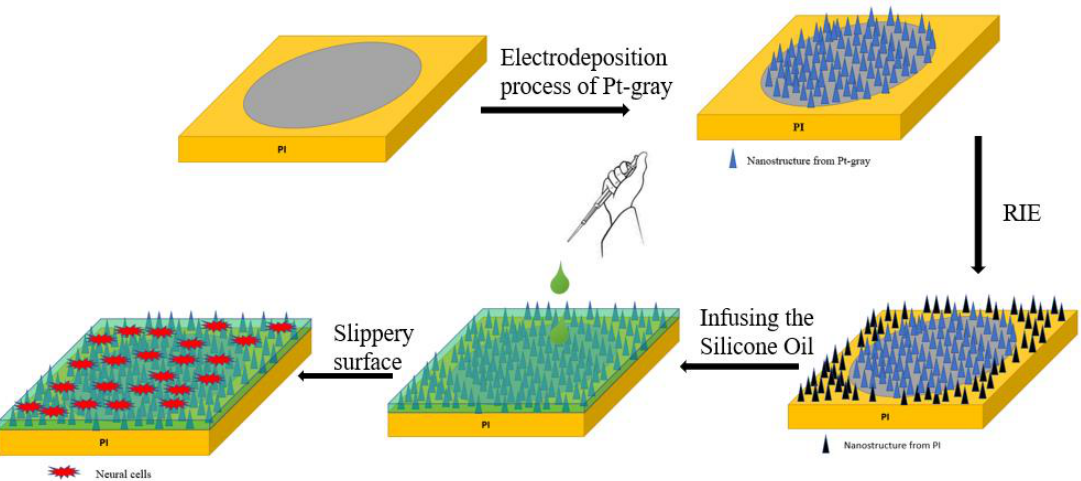
Figure 3. The schematic of the SLIPS coated procedure by pipetting the silicone oil on the electrode surface.